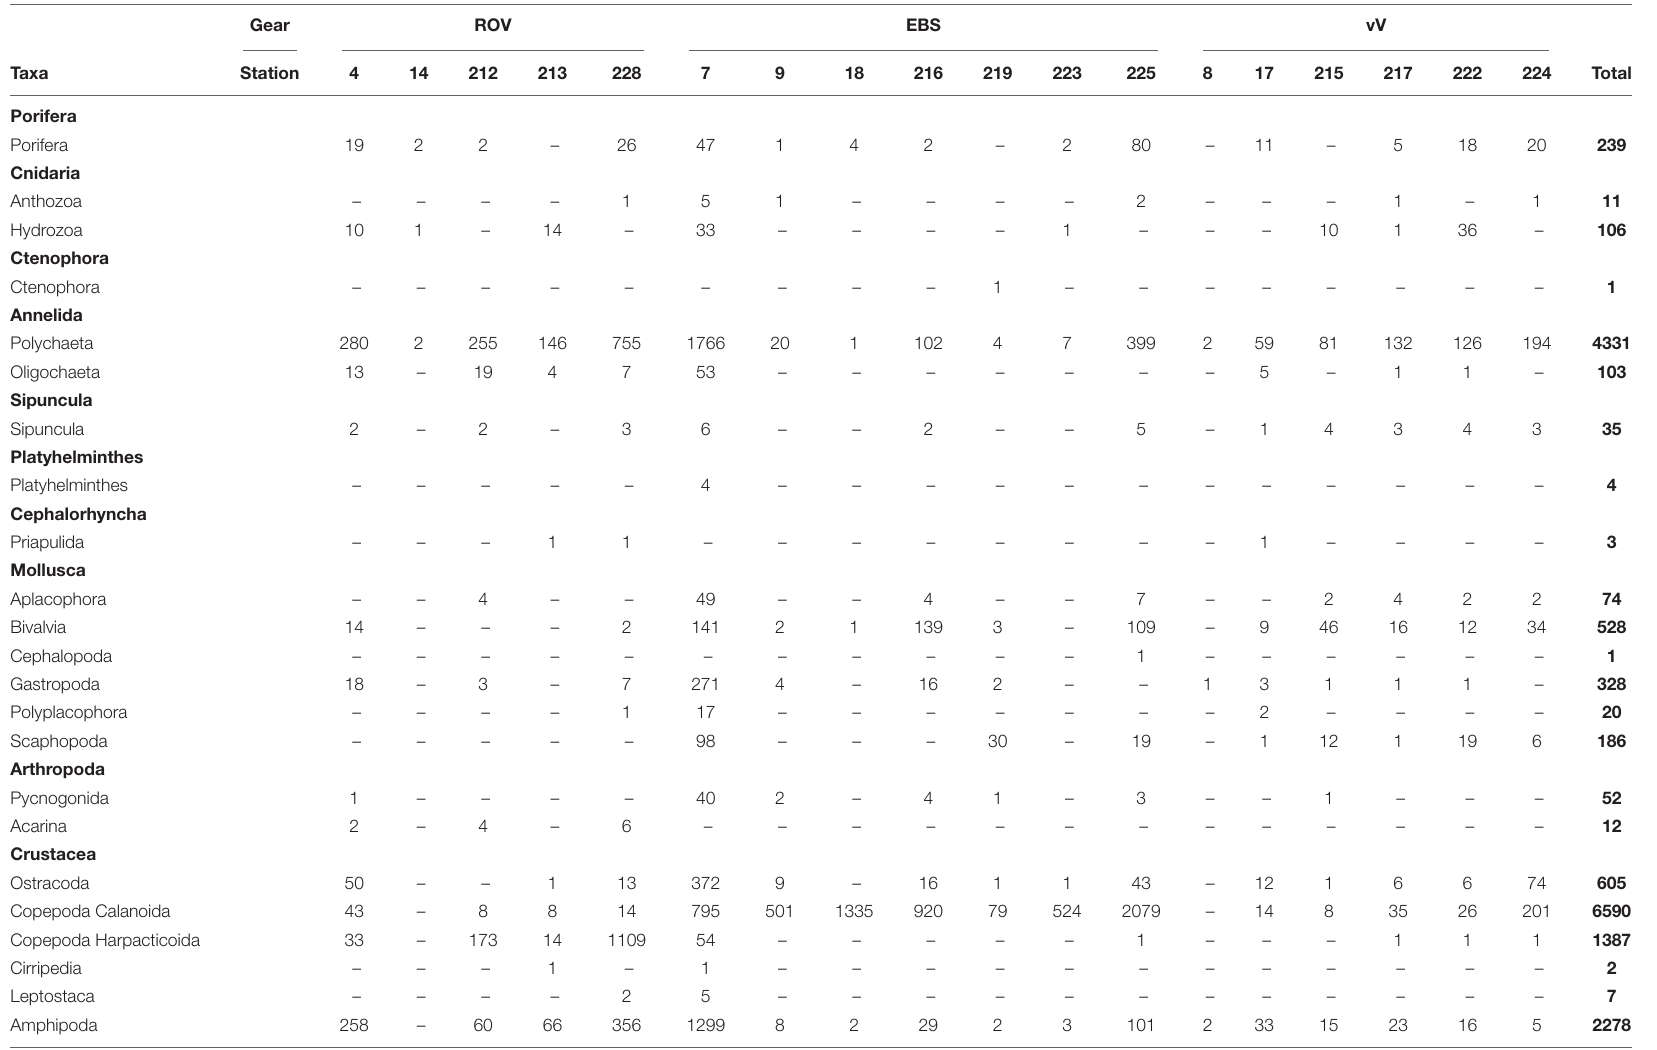
TABLE 2 | Faunal composition showing total individuals of each taxa sampled at the Steinahóll vent fields. Gear ROV EBS vV